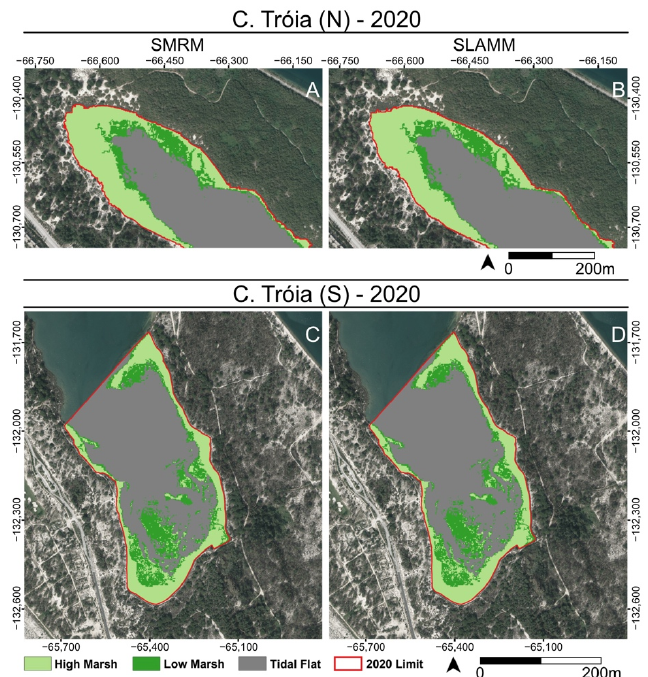
Figure 5. Modeled morphological map for 2020 for C. Tróia (N) and (S), using SMRM ( A , C ) and SLAMM ( B , D ). Coordinate system: ETRS1989 (PT06). Basemap: 2014–2015 DGT Orthophotos. Considering IPCC RCP4.5 (SLR of 65 cm until 2100), SMRM projects that C. Tróia (N) will maintain its area until 2050 and a loss of only 3% is expected until 2100 (4.33 ha)